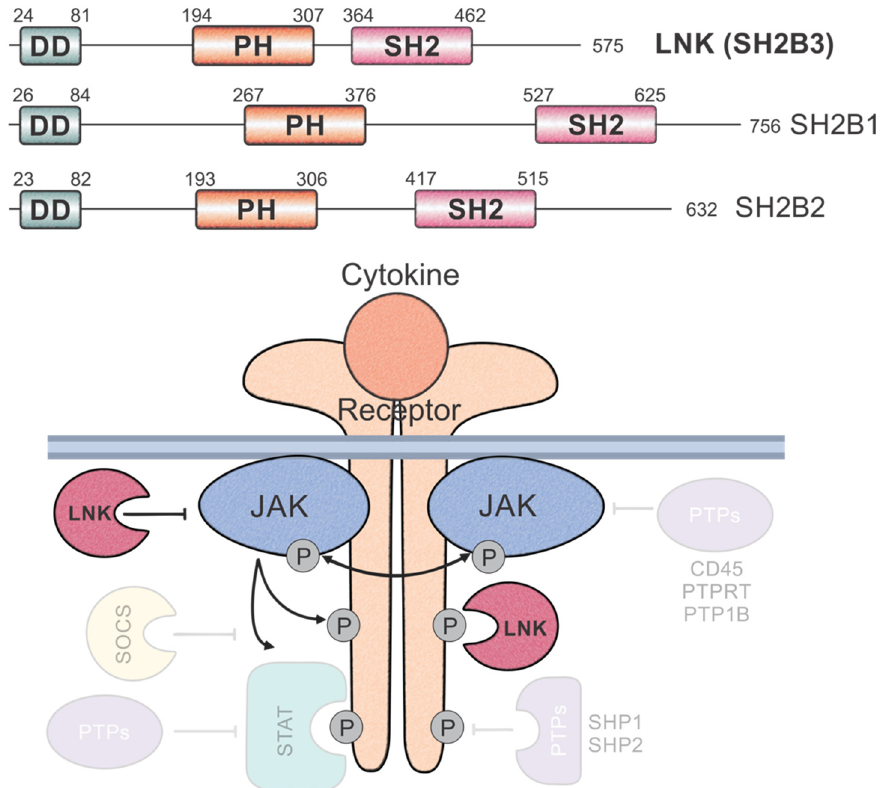
Figure 1. LNK and the adaptor family of proteins. The SH2 domain-containing adaptor family of proteins all share the same domain architecture ( top ) comprising an N-terminal dimerisation domain (DD), central pleckstrin homology domain (PH) and C-terminal Src homology 2 (SH2) domain. Schematic diagram of cytokine signalling showing regulators of cytokine signalling and where they act ( bottom ). Phosphatases and Suppressor of Cytokine Signalling (SOCS) proteins are shown semi-transparently, whereas LNK is shown in solid colour. LNK directly binds JAKs and receptors via its SH2 domain and inhibits downstream signalling.